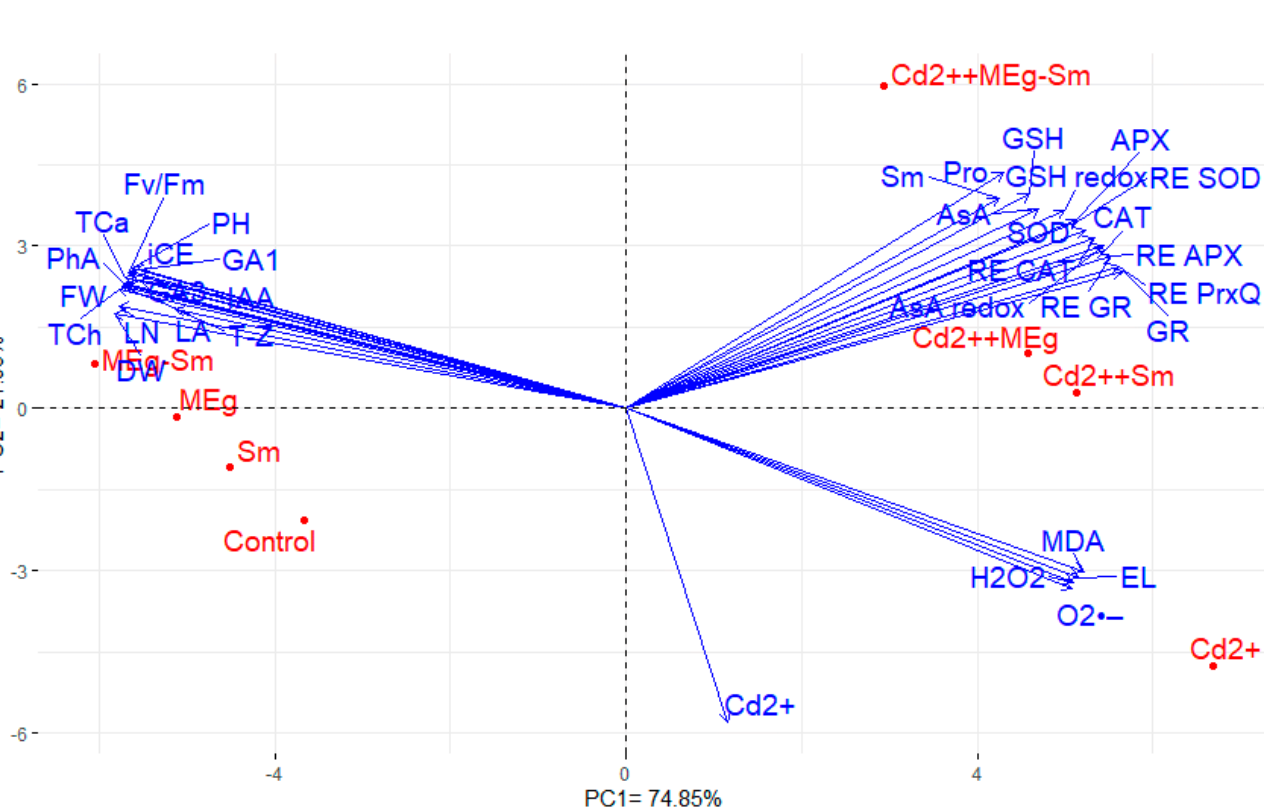
Figure 6. Biplot of analysis of prime components demonstrating the relationship among the traits assessed. Plant height (PH), number of leaves (LN), total leaf area (LA), shoot fresh weight (FW), shoot dry weight (DW), instantaneous carboxylation efficiency (iCE), photosystem II efficiency (Fv/Fm), total chlorophyll (TCh), carotenoid contents ((TCa), photochemical activity (PhA), superoxide (O2 •− ), hydrogen peroxide (H2O2), lipid peroxidation as malondialdehyde (MDA), ionic leakage (EL), cadmium (Cd2+), proline (Pro), ascorbate (AsA), glutathione (GSH), ascorbate redox state (AsA redox), glutathione redox state (GSH redox), silymarin (Sm), superoxide dismutase (SOD), catalase (CAT), ascorbate peroxidase (APX), glutathione reductase (GR), relative expression of SOD (RE SOD), relative expression of CAT (RE CAT), relative expression of APX (RE APX), relative expression of GR (RE GR), relative expression of PrxQ (RE PrxQ), indole-3-acetic acid (IAA), gibberellic acids 1 and 3 (GA1 and GA3), and cytokinin trans-zeatin (T-Z).